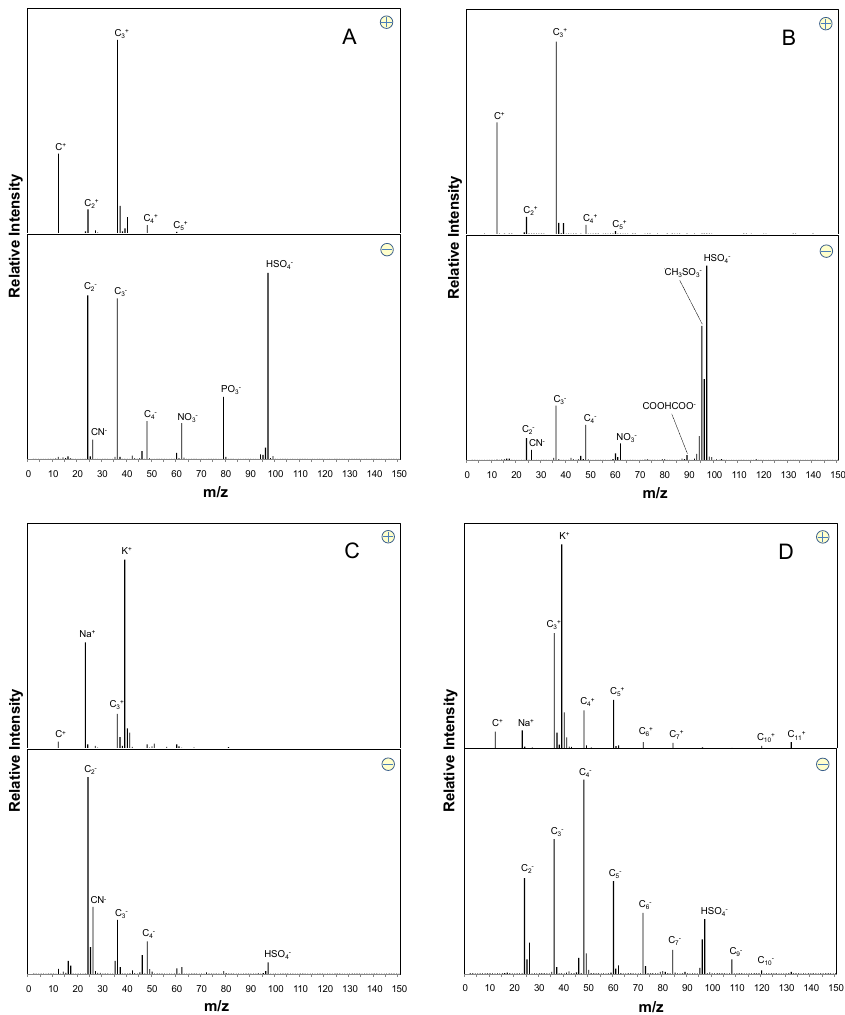
Fig. 12. Average dual ion mass spectra of ATOFMS particle classes; (A) EC-phos, (B) EC-MSA, (C) EC-domestic (D)